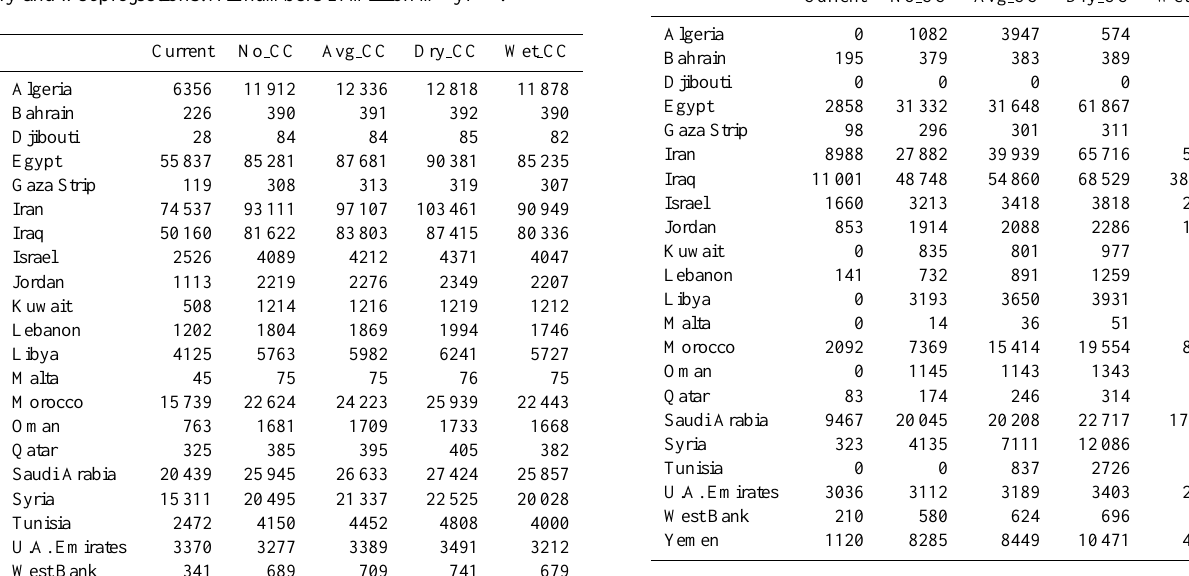
Table 2. Annual water demand for the 22 countries for the current (2001–2010) and future (2041–2050) periods. Future projections in- clude ignoring climate change (No CC), and scenarios for average, dry and wet projections. All numbers in million m 3 yr − 1 .